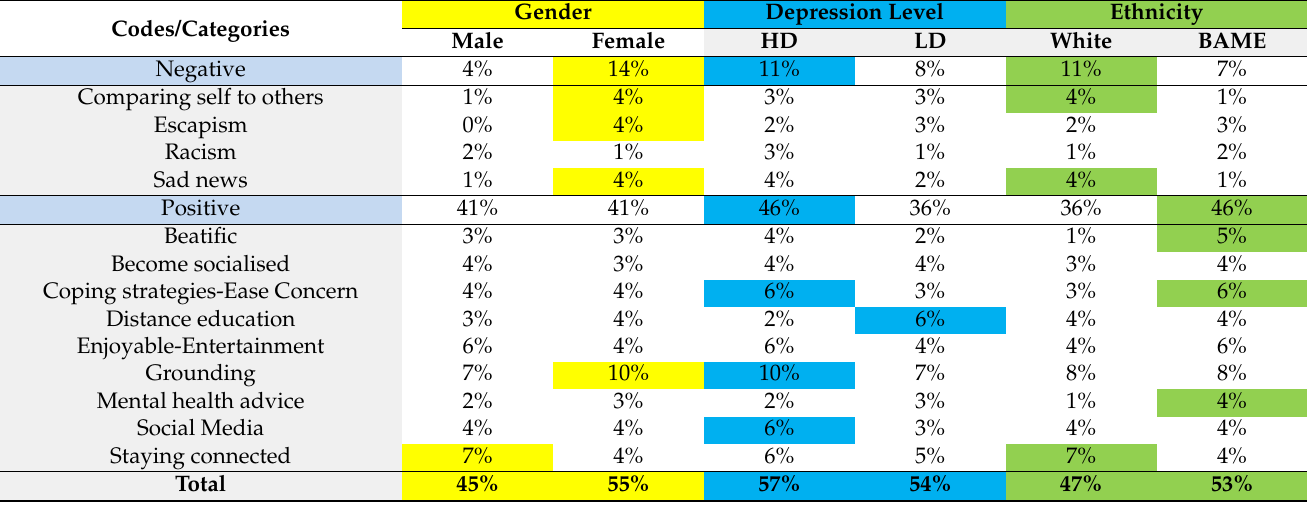
Table A1. The effects of gender, ethnicity and depression level on internet.